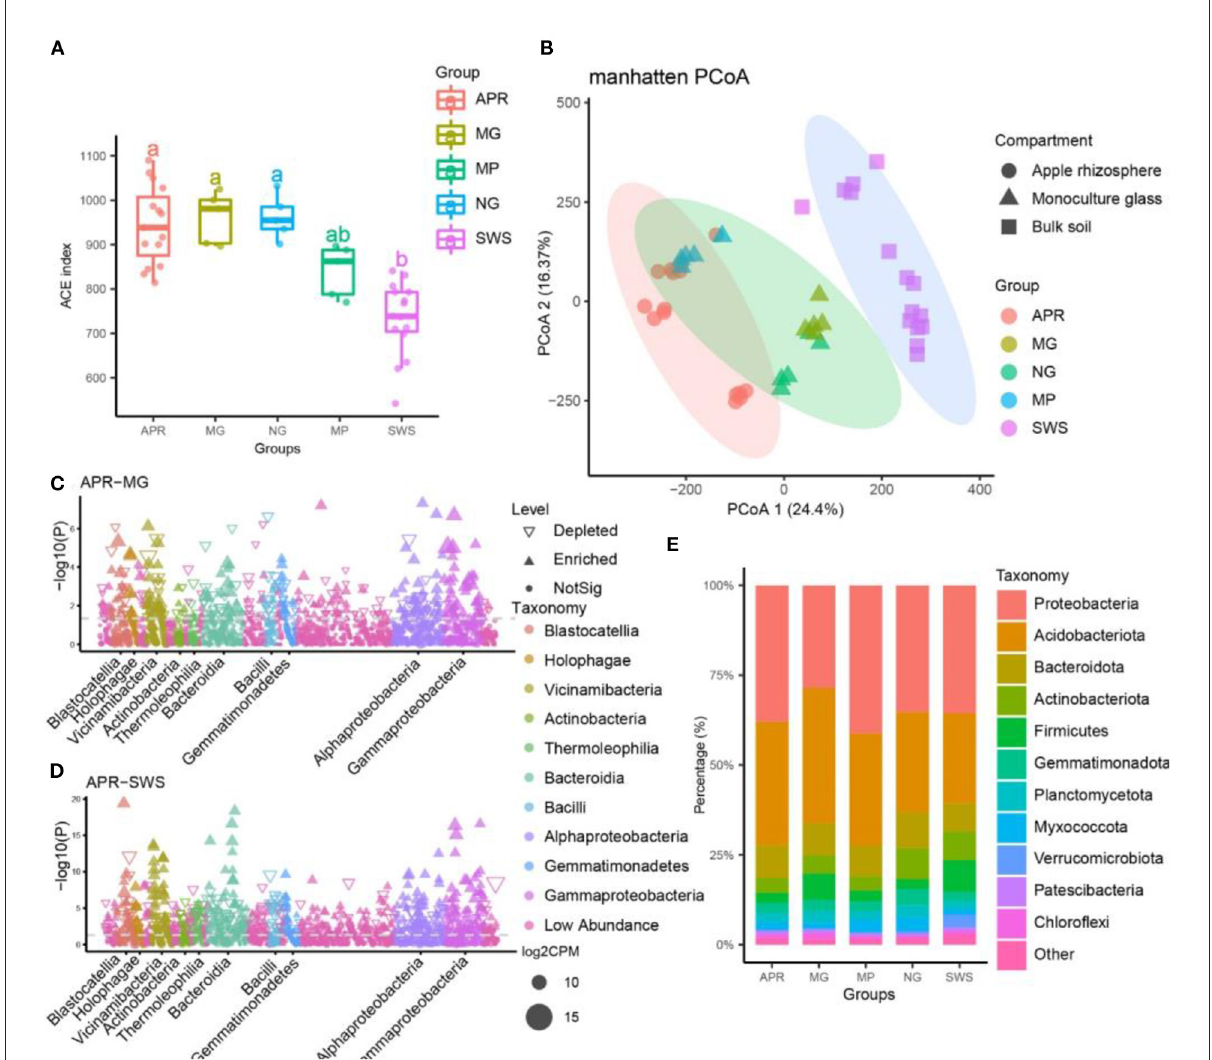
FIGURE1 Microbial diversity of apple, intercropping plants, and sandy waste soil (SWS). (A) Microbial diversity of different groups according to the ACE index. The lines inside the boxes represent the median values (95% confidence). The significant differences in the alpha indices between groups are indicated by different lowercase letters ( p < 0.05). (B) Manhattan distance analysis of bacterial communities from different samples (principal coordinates PCo1 and PCo2). The microbiomes of apple, intercropping plants and SWS were significantly separated from each other along the two axes ( P < 0.001, permutational multivariate analysis of variance, PERMANOVA). The ellipses cover 90% of each group. (C,D) Manhattan plots present significantly enriched bacterial operational taxonomic units (OTUs) in the apple vs. licorice (C) and apple vs. SWS (D) comparisons. (E) Relative abundance of the predominant bacteria (at the phylum level) in different samples. APR, root soil of apple plant; MG, root soil of licorice; NG, root soil of natural grass; MP, root soil of pepper plant; SWS, soil of sandy waste.